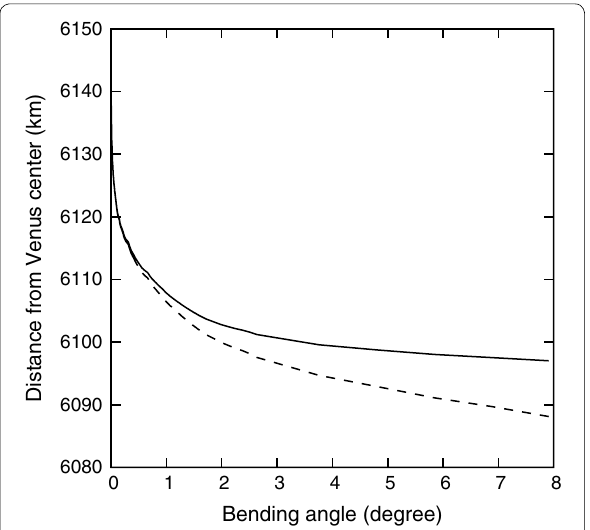
Fig. 5 Relationship between the bending angle and the impact parameter (solid) and that between the bending angle and the ray closest distance (dashed) calculated for the ingress observation conducted on May 6, 2016